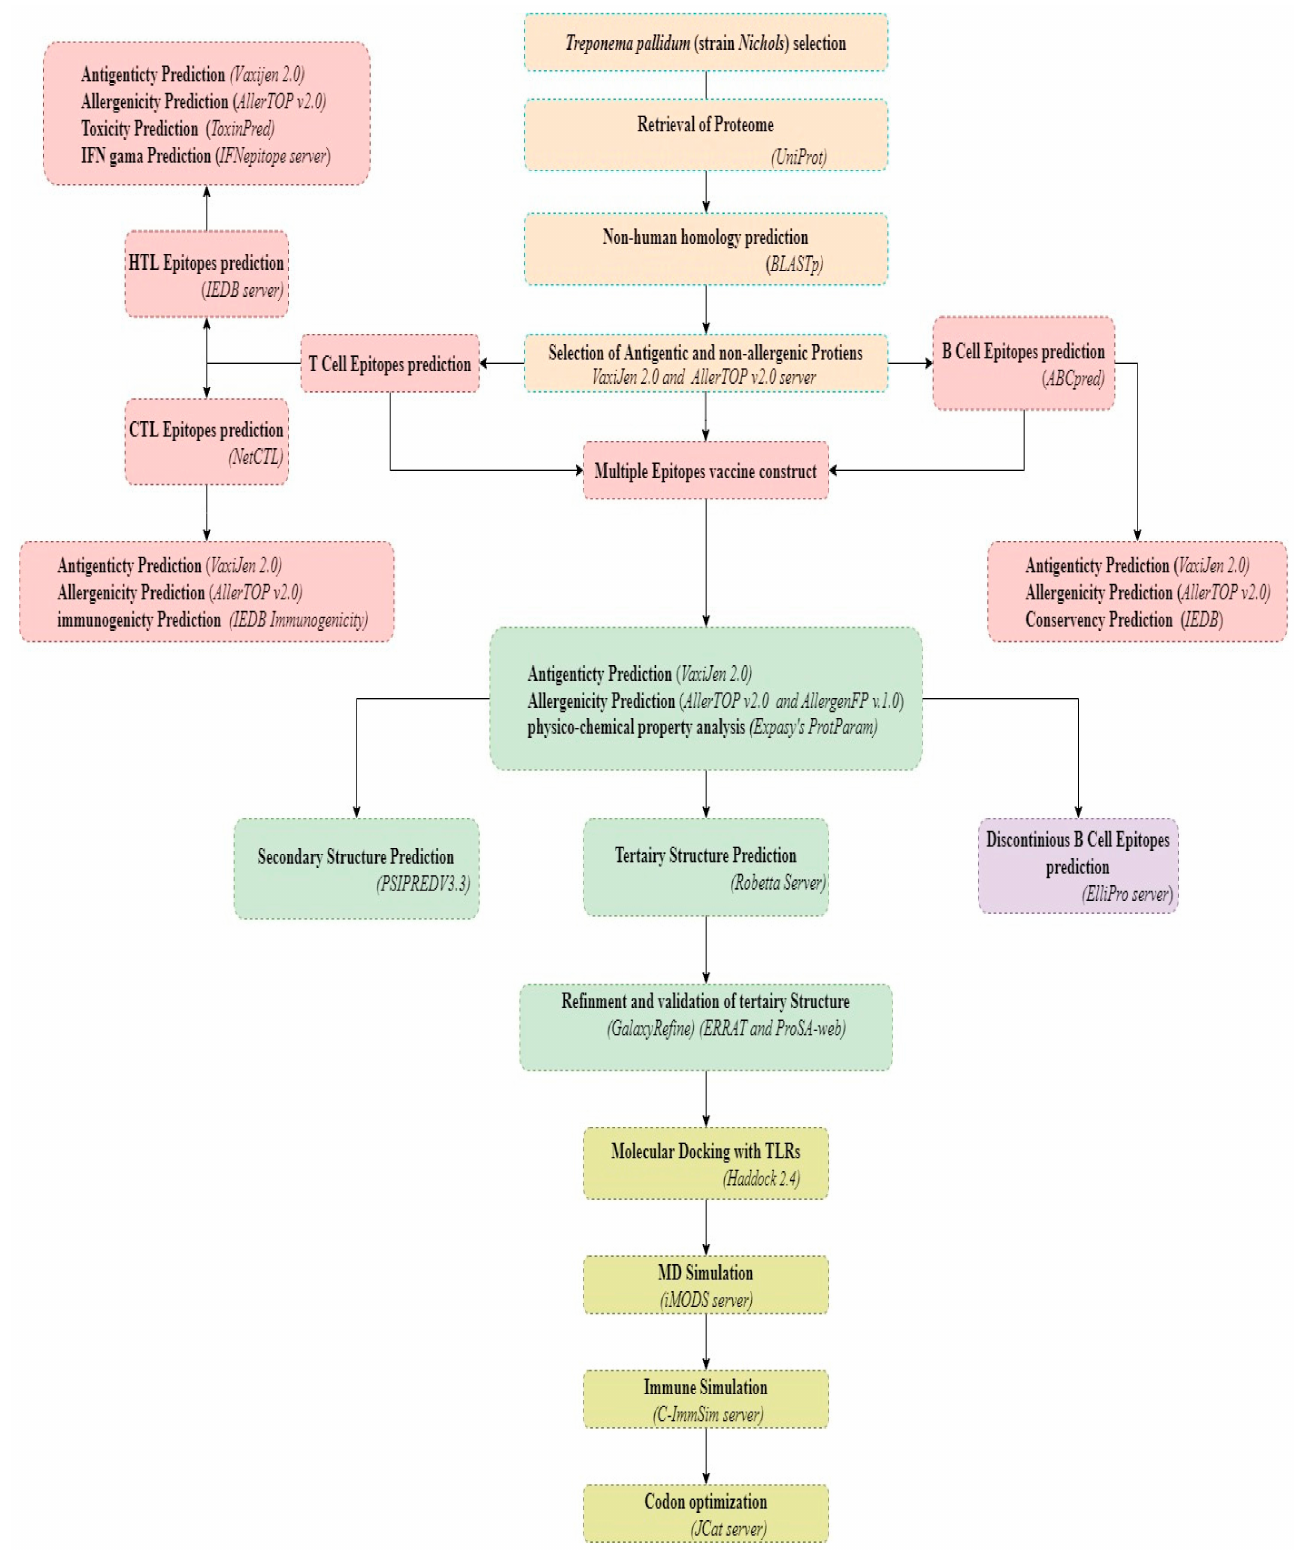
Figure 1. The flowchart represents the overall methodology for developing a multi-epitope subunit vaccine